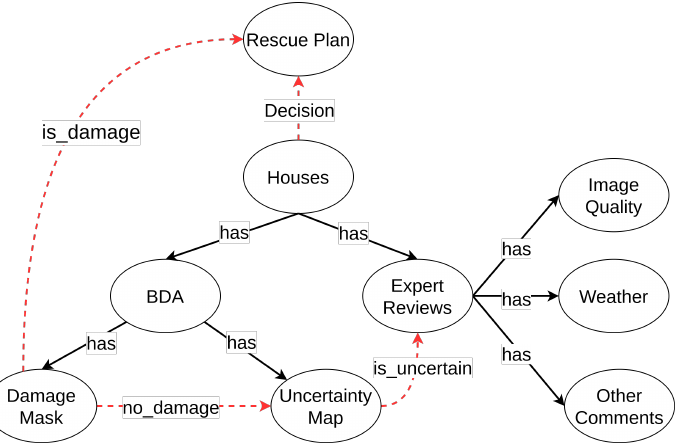
Figure 5. The illustration of the logical ontology in robust operation. The dashed arrow indicates the logical flow between entities.